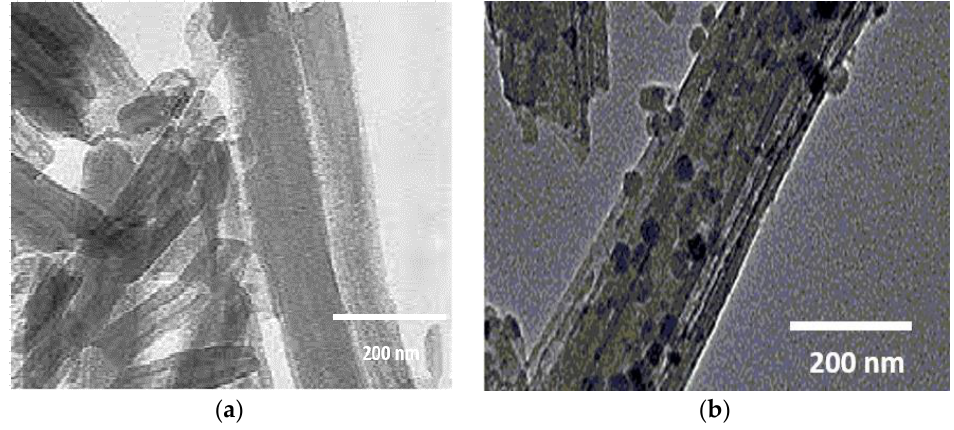
Figure 8. TEM of ( a ) halloysite and ( b ) magnetic halloysite.